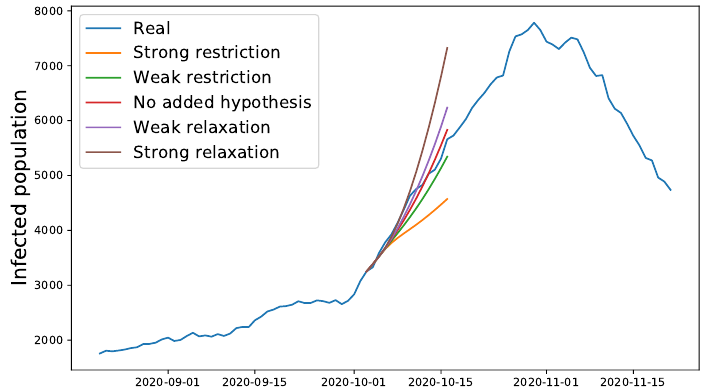
Figure 6. Prediction of the evolution of the number of positive cases from 4 September. The series show the different predictions when various hypothesis on the restriction measures are used in the system. The prediction curves extend up to 20 days, which is the intended prediction